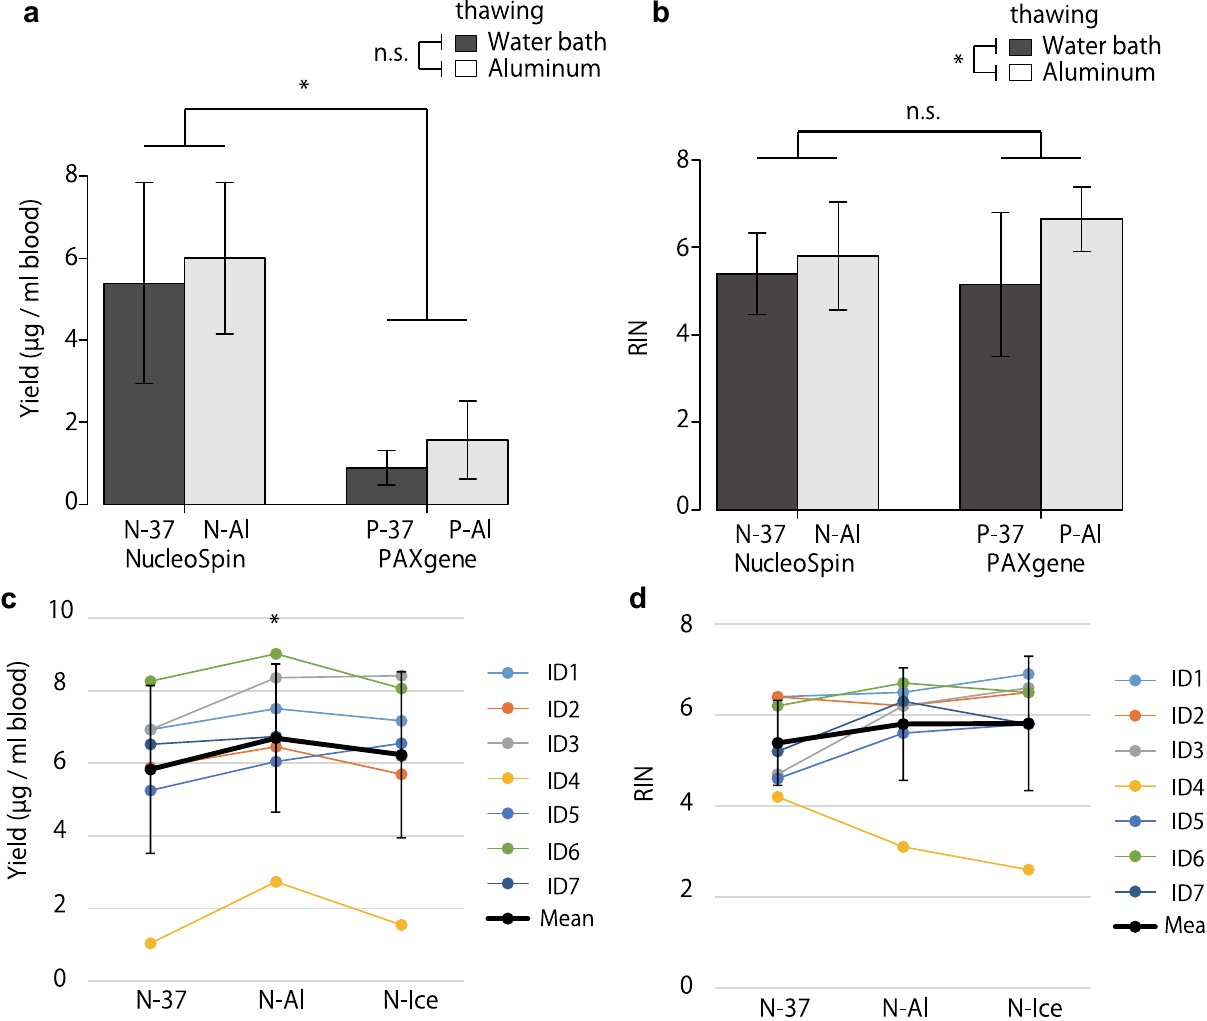
Figure 2. Comparison of yield and RNA integrity number (RIN) of RNA isolated from whole blood samples. ( a,b ) Comparison of ( a ) yield and ( b ) RIN of RNA among protocols P-37, P-Al, N-37, and N-Al. Data are shown as mean ± standard deviation (n = 7). * p < 0.05 (two-way analysis of variance) for ( a ) NucleoSpin versus PAXgene, or ( b ) thawing in a water bath versus thawing on an aluminum block. ( c,d ) Comparison of ( c ) yield and ( d ) RIN of RNA among protocols N-37, N-Al, and N-Ice. * p < 0.05 (repeated-measures analysis of variance with Bonferroni correction) for N-37 versus N-Al. n.s. not significant. The images were created using